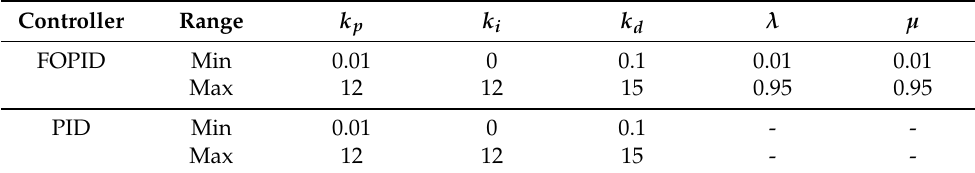
Figure 6. GWO flowchart. Table 2. FOPID and PID upper and lower